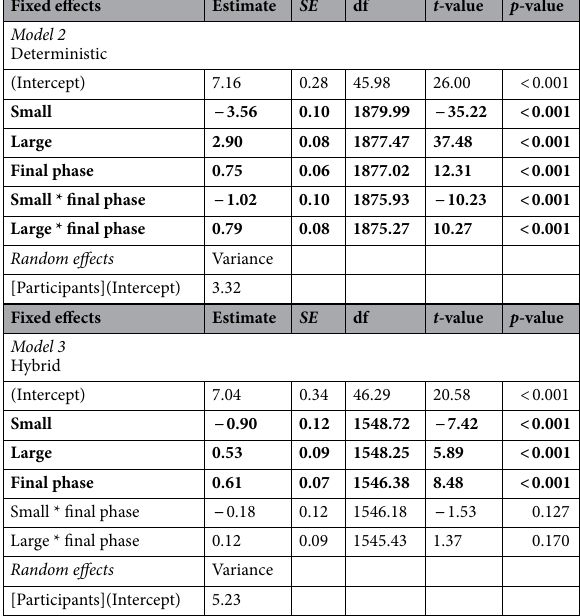
Table 3. Summary of linear mixed-effects models testing the sensitivity to the different balloon tolerances (balloon sizes) in the deterministic and hybrid conditions (Models 2–3). Dependent variable in both models: Number of pumps on non-burst balloons. Coding scheme: sum coding. The reference levels of the factors were medium balloon size and first phase. Significant effects are in bold (except the intercept). SE : standard error.